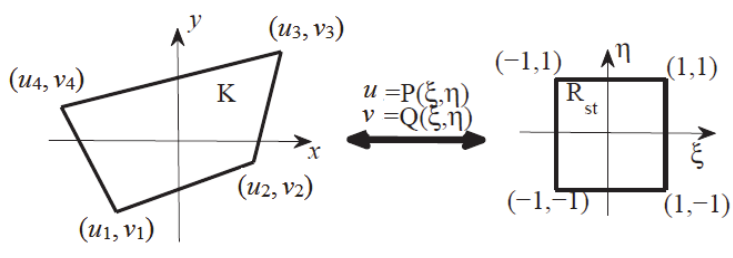
Figure 3: Isoparametric linear